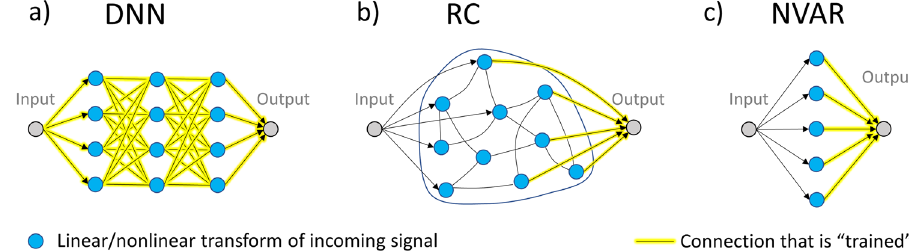
Fig. 1 Visualization of different machine learning architectures. Topology and training scheme for the three different concepts discussed in this comment. DNN deep neural networks; RC reservoir computing, NVAR nonlinear vector-auto-regression.